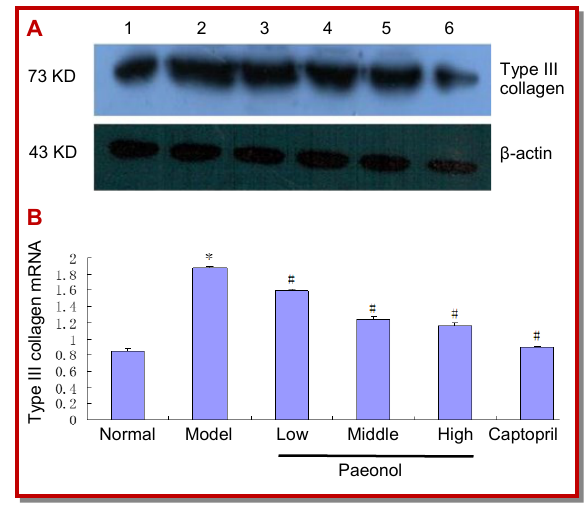
Figure 4: Type III collagen expression of cardiac fibroblasts in each group by Western blot. 1-the normal control group; 2-the aldosterone model group; 3-the low-dose group of paeonol; 4- the middle-dose group of paeonol; 5-the high-dose group of paeonol; 6-the captopril group; M Marker (A); Compared with the normal control group, *p < 0.01; compared with the model group, # p < 0.01 enhanced in the high-dose group of paeonol (p<0.01). Compared with the model group, the protein